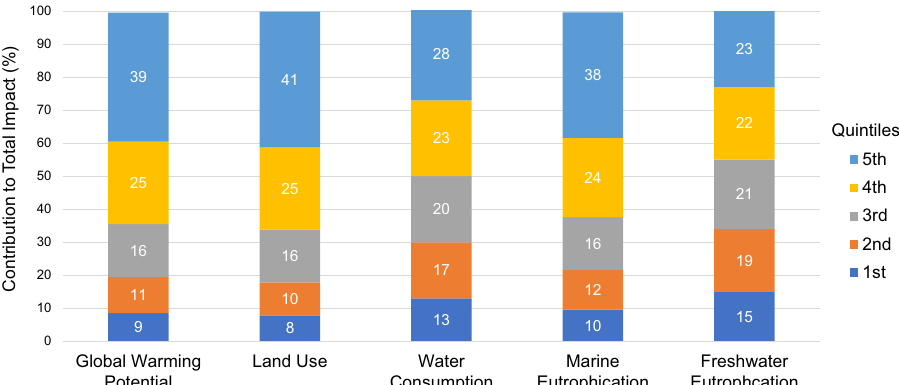
Fig. 1 Percent contribution of quintiles to the total environmental impact of lunches served in the National School Lunch Program by impact category. Caption: Lunch impacts for each impact category are divided into quintiles; each quintile represents 20% of lunches and is identi fi ed by a different color. Quintiles are stacked from 1 st to 5 th . Contribution of impacts from quintiles vary considerably across impact categories, with lunch impacts in the 4 th and 5 th quintile accounting for most of the total impact. Table 2 Average composition of lunches served by